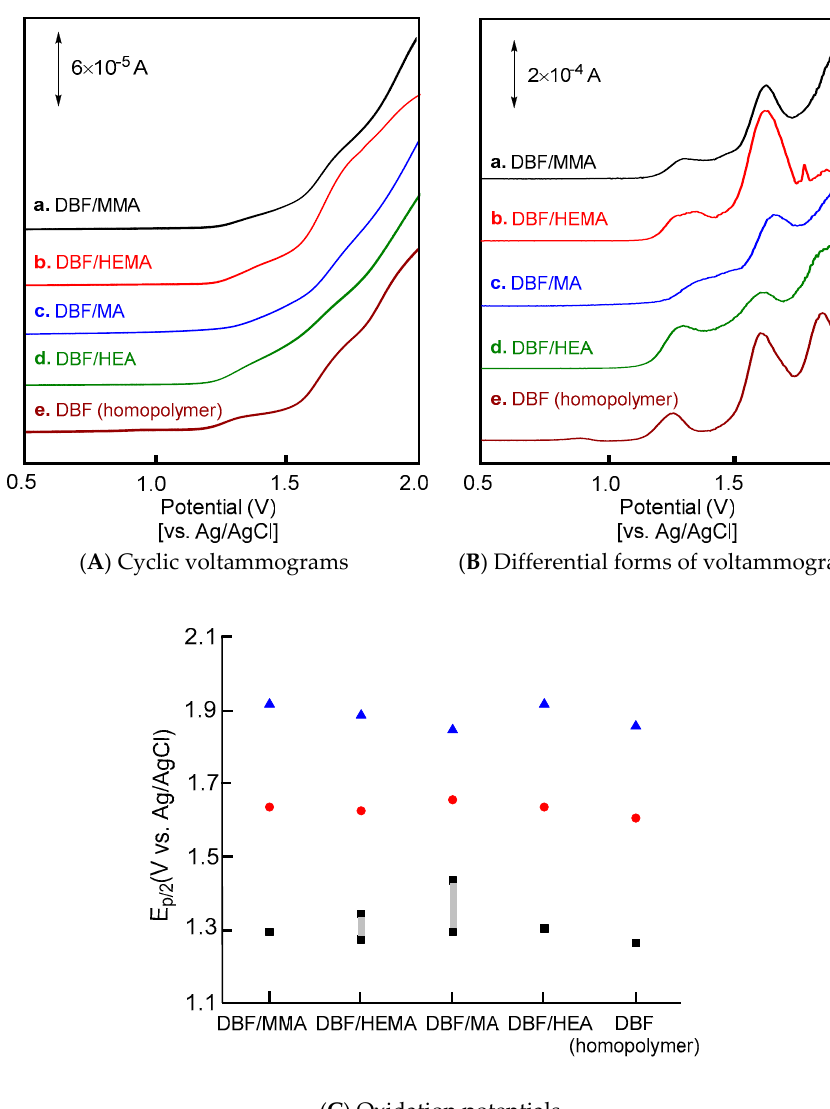
Figure 4. Cyclic voltammetry (CV) profiles ( A ), their differential forms ( B ) and oxidation potentials summary ( C ) of poly(DBF- co -MMA) ([DBF]/[MMA] in polymer = 82/18) (a), poly(DBF- co -HEMA) ([DBF]/[HEMA] in polymer = 73/27) (b), poly(DBF- co -MA) ([DBF]/[MA] in polymer = 87/13) (c), and poly(DBF- co -HEA) ([DBF]/[HEA] in polymer = 89/11) (d) (CV measurement conditions: CH 2 Cl 2 solution containing n- Bu 4 NPF 6 , room